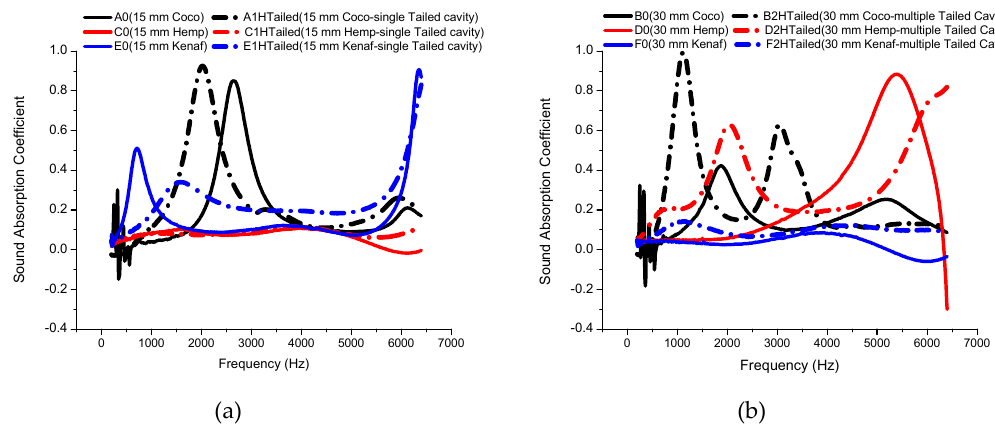
Figure 3. Biomass fiber with: ( a ) single; ( b ) multiple tailed cavity inclusion.